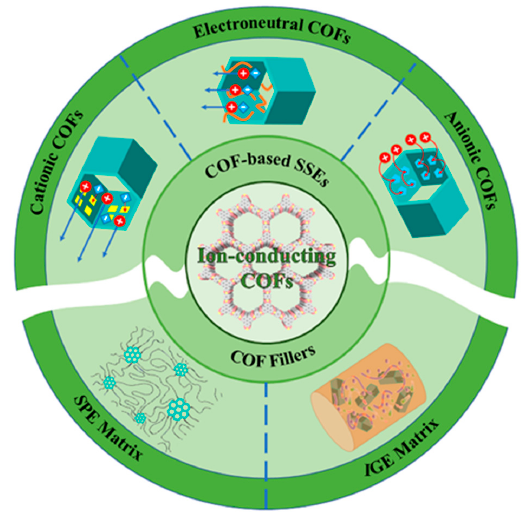
Figure 4. Schematics of applications for ion-conducting COFs in SSEs .